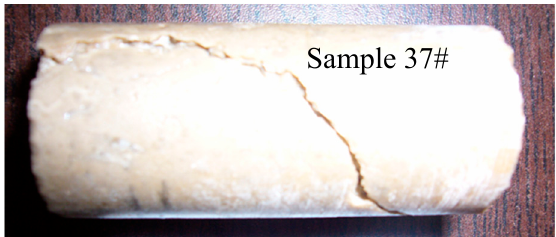
Processes 2019 , 7 , x FOR PEER REVIEW Figure 6. Morphology of sample 37 after acid fracturing. Figure 6. Morphology of sample 37 after acid fracturing.